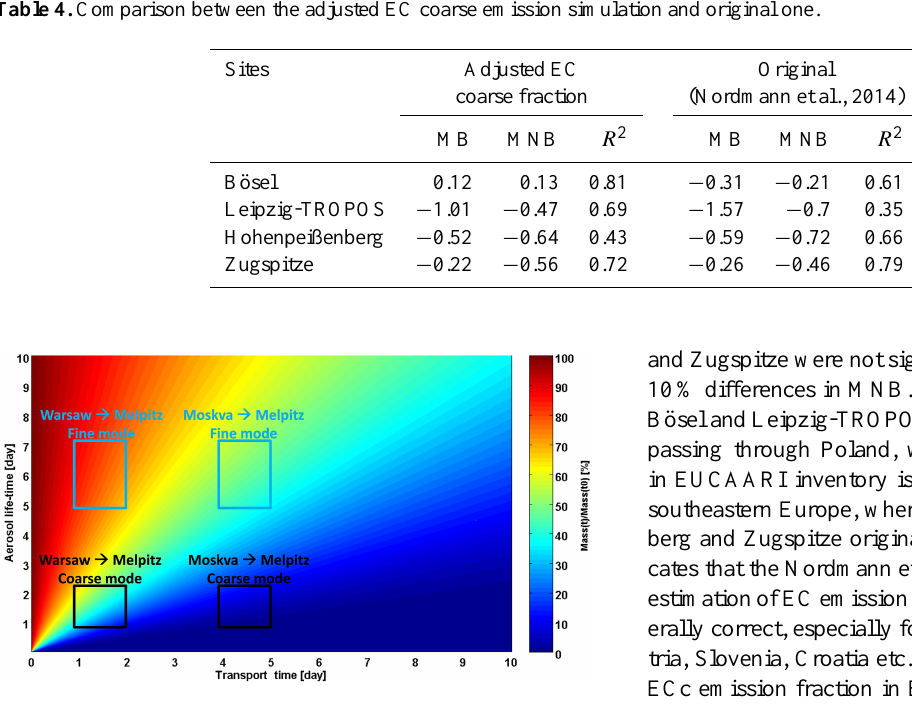
Table 4. Comparison between the adjusted EC coarse emission simulation and original one.